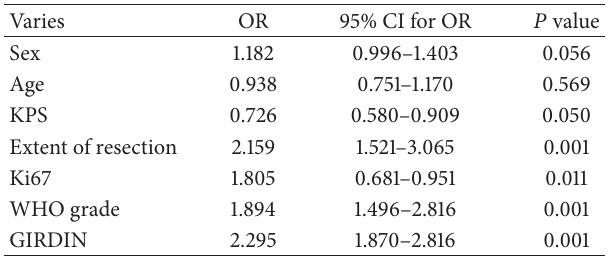
Table 3: Cox model regression analysis of prognostic factors for the